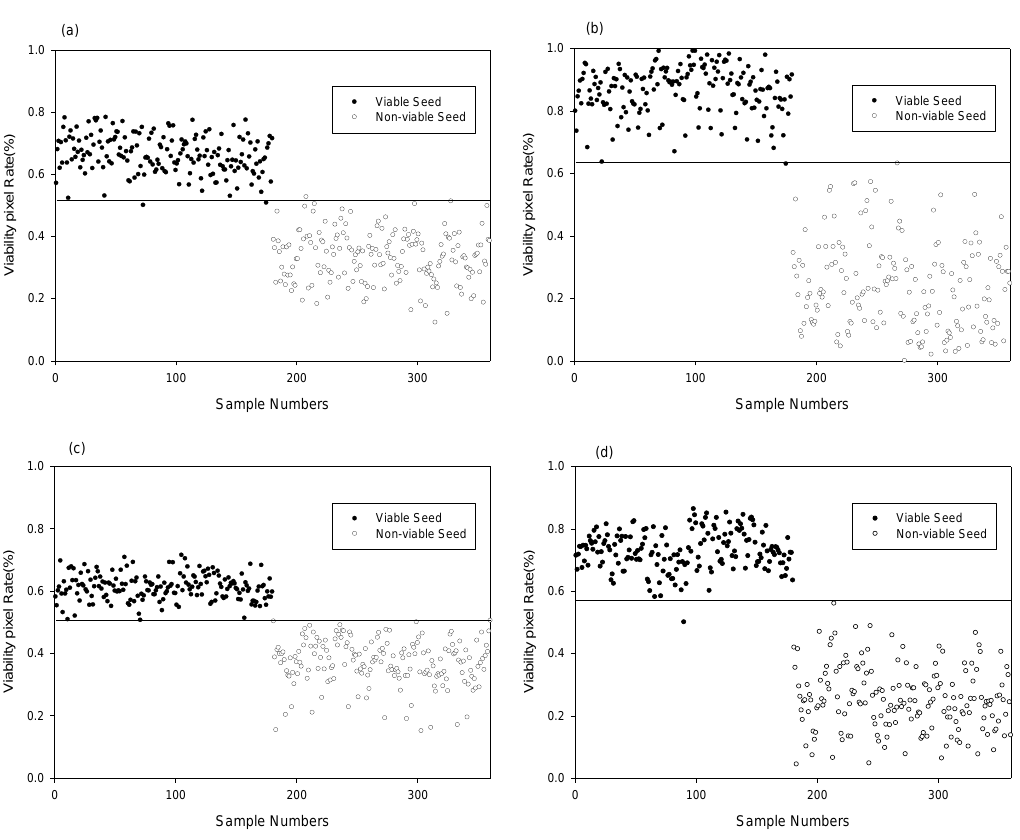
Figure 9. PLS image prediction results obtained when discriminating between viable and nonviable pepper seeds using spectral images of seeds illuminated by: ( a ) BL (400–500 nm), ( b ) GL (500–600 nm), ( c ) RL (600–700 nm), and ( d ) a RGB LED (400–700 nm), where the PLS-DA was